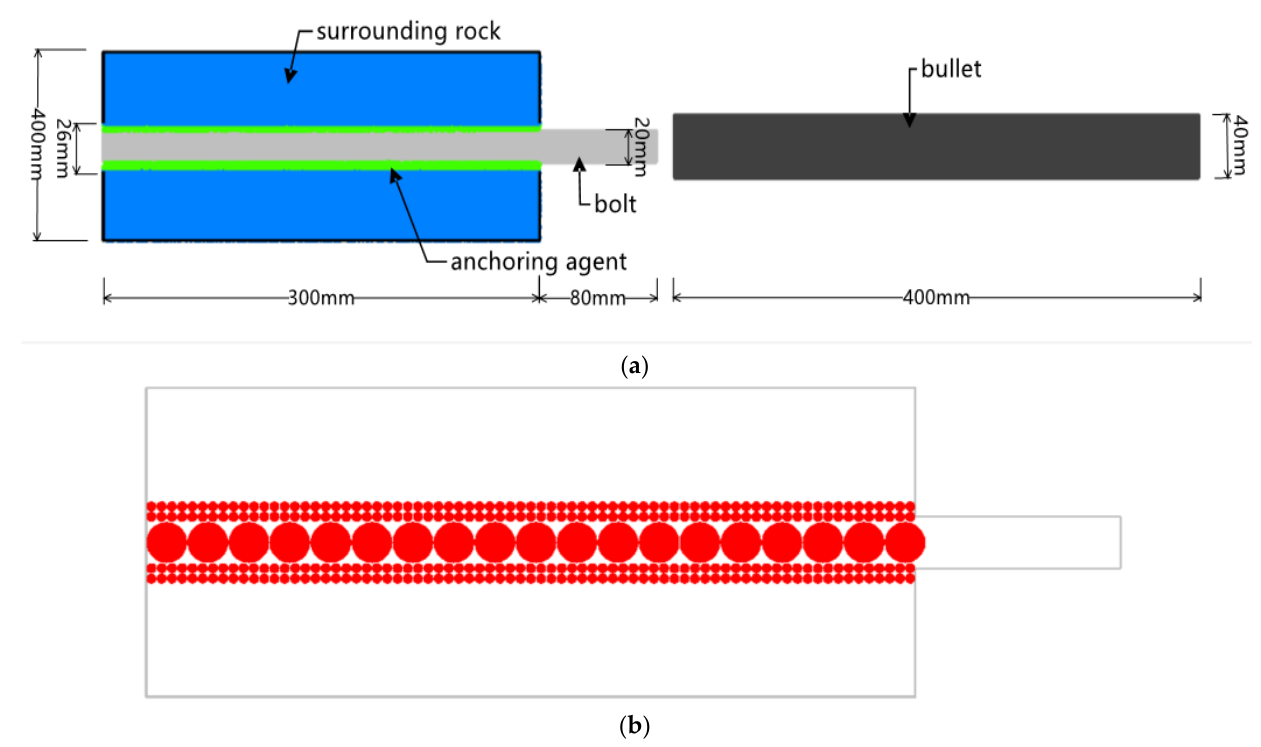
Figure 11. Dynamic impact test model and measuring circle location figure of PFC2D. ( a ) Dynamic impact test model of PFC2D ( b ) Measuring circle plan . Table 1. Main parameters of PFC2D.